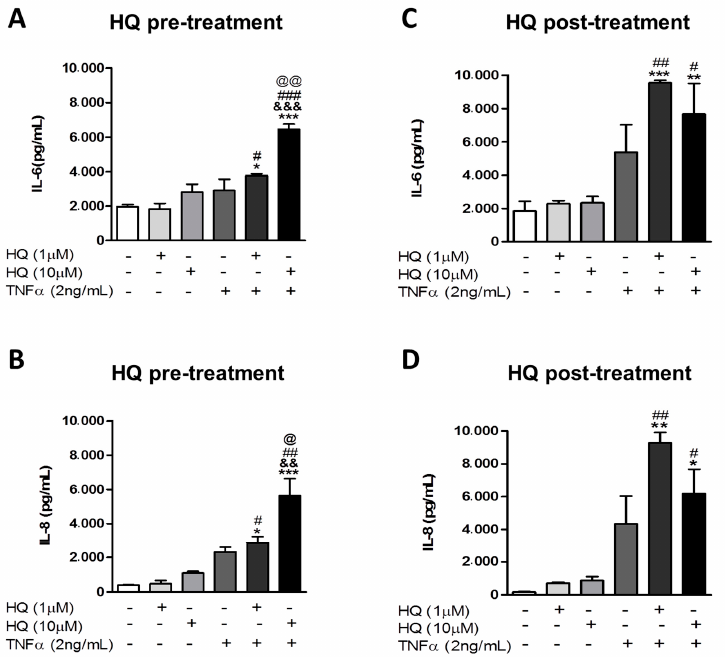
Figure 2. In vitro HQ exposure potentiates the production of pro-inflammatory cytokine by RAHFLS when combined with TNF- α treatment. RAHFLS (1 × 10 4 cells) were pre- ( A , B ) or post-incubated ( C , D ) with culture medium or with HQ (1 or 10 µ M) for 4 h, followed by the incubation with or without TNF- α (2 ng/mL) for 20 h. Supernatants were harvested and had the levels of interleukin (IL)- 6 and -8 quantified through ELISA. Data represent mean ± SEM from three independent